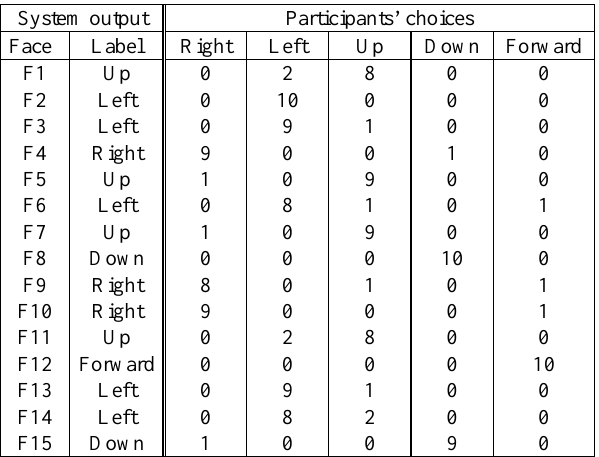
Table 1 . Face Direction Tracking Evaluation Study Results.